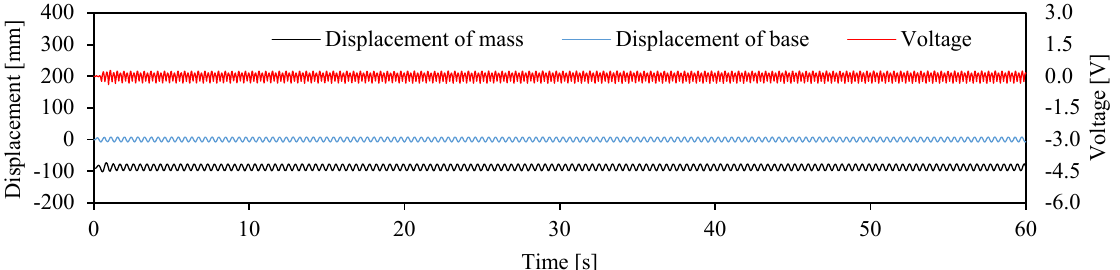
When the excitation frequency was 2.2 Hz, as shown in Figure 15, the amplitude of